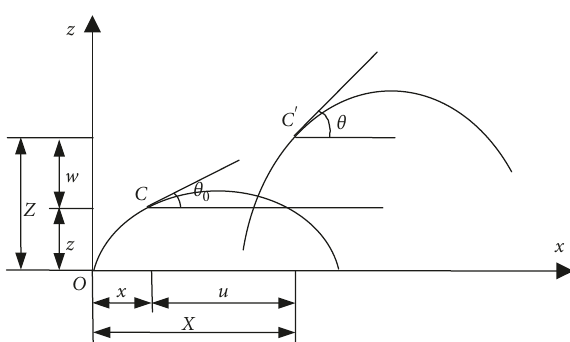
Figure 1: Schematic diagram of the curved beam’s